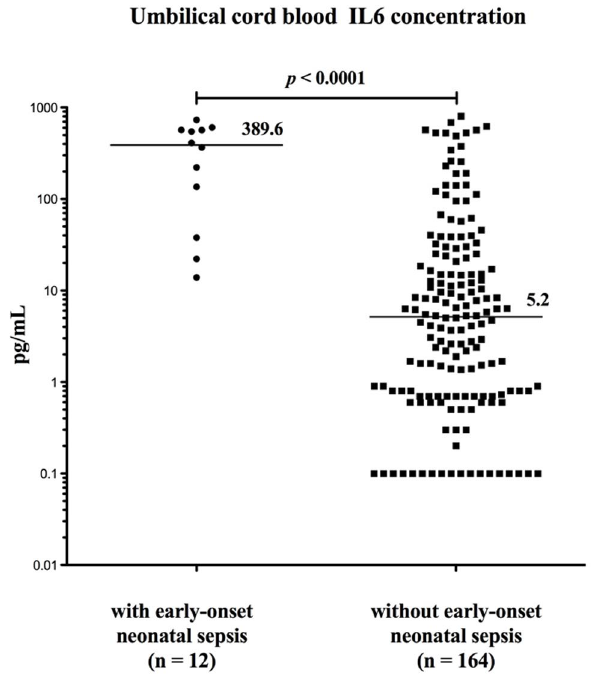
Figure 1. Distribution of umbilical cord blood IL6 according the occurrence of early onset neonatal sepsis.